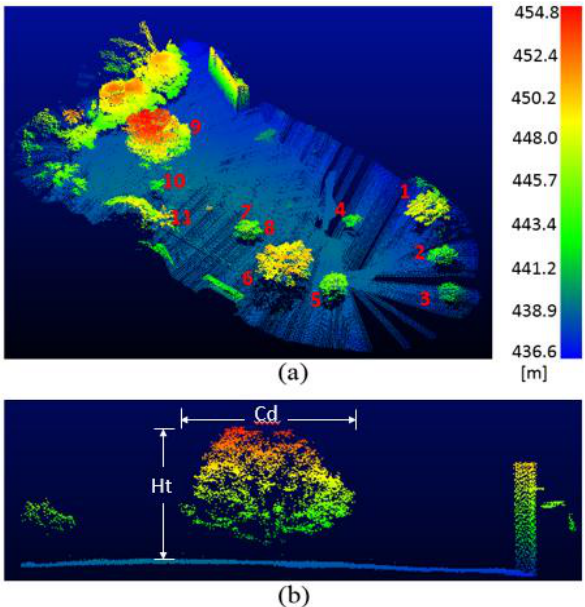
Figure 2. UAV- LiDAR point cloud: (a) three-dimensional view of the point cloud and (b) lateral profile showing mainly the structure of a